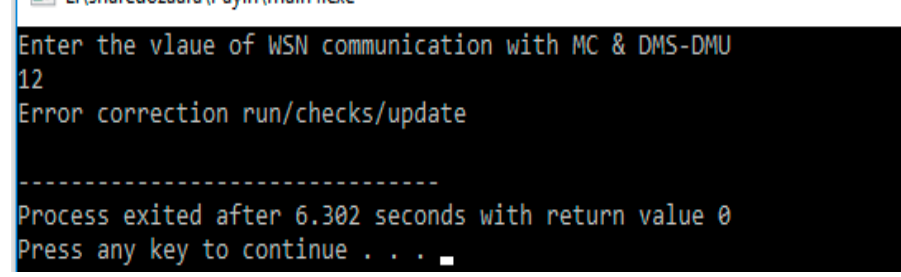
Figure 5. Default error input simulation.